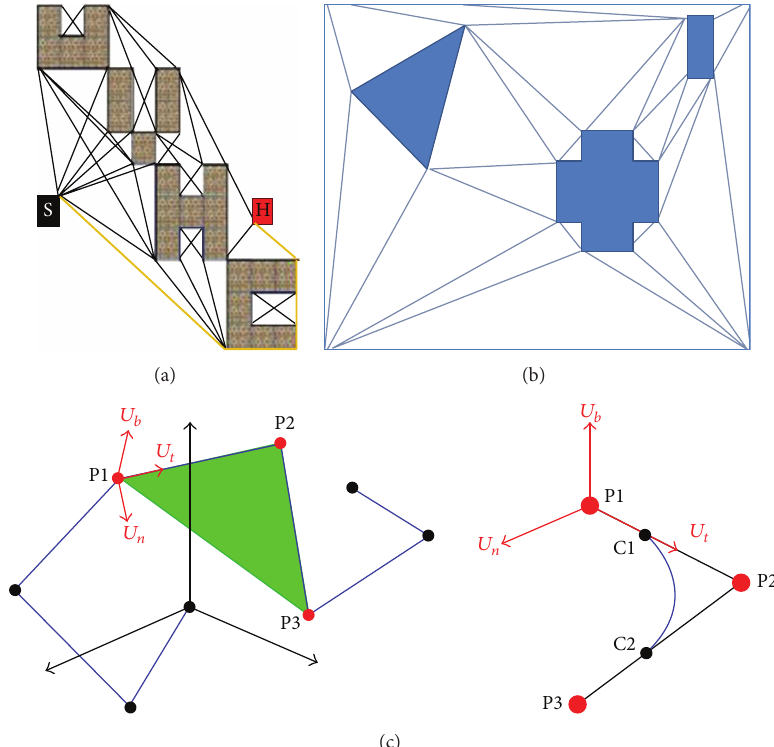
Figure 3: (a) Visibility graph (brown represents obstacles), (b) mesh navigation with triangular grid (blue regions represent obstacles), (c) 3D G2CBS path smoothing: three consecutive points in space from a unique 2D plane (left); planar G2CBS path smoothing is applied to these consecutive points after mapping 3D waypoints to 2D (right)